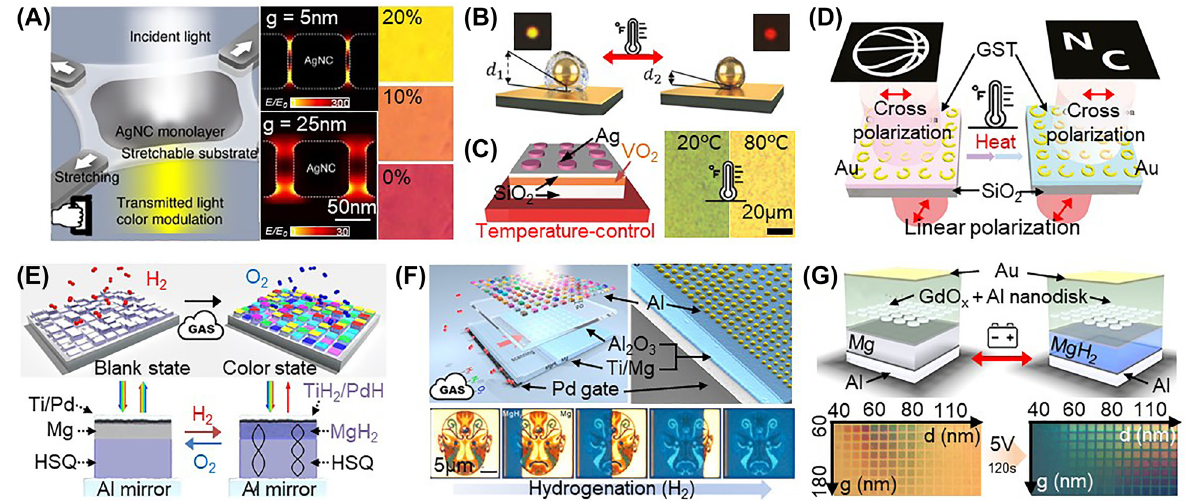
Figure 4: Various responsive plasmonic nanopixels with the refractive index modulation, Δ n surrounding the nanoparticle. Mechanochromic nanopixels driven by (A) physical strain (reproduced with permission [107], Copyright 2018, Wiley-VCH) and (B) heat (or laser) (reproduced with permission [106], Copyright 2018, Wiley-VCH). Thermo-chromic nanopixels for (C) coloration (reproduced with permission[105], Copyright 2018, Wiley-VCH), (D) dynamicholographic images (reproduced with permission[120], Copyright 2020, Walter de Gruyter GmbH), and (E – G) hydrogenation-based color dynamics (reproduced with permission [117 – 119], Copyright, 2019, Springer Nature, 2018 American Chemical Society, and 2017, American Chemical